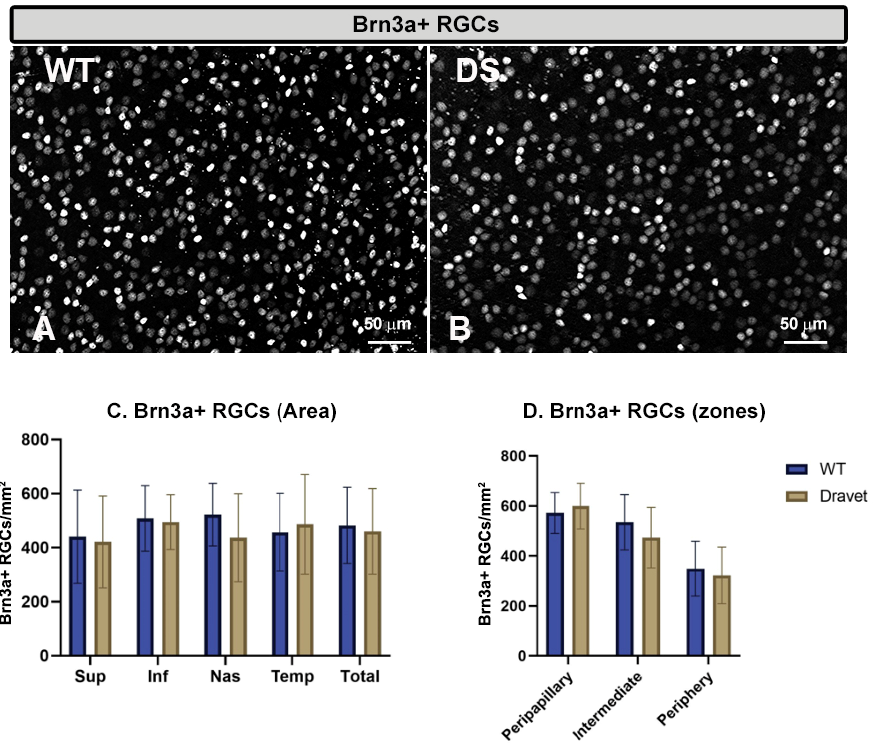
Figure 6. Retinal GABAergic amacrine cell number. ( A , B ): retinal whole-mounts labeled with anti- GAD65+67 at 40 × magnification in WT animals ( A ) and in Dravet syndrome (DS) animals ( B ). ( C , D ): number of GABAergic GAD65+67 amacrine cells per retinal area 0.0376 mm 2 by total retina and areas ( C ) and by zones ( D ). Two-way ANOVA. Data expressed as mean value ( ± SD). Number of retinas used in the experiment: WT animals n = 6, DS animals n = 6. Sup: superior; Inf: inferior; Nas: nasal; Temp: